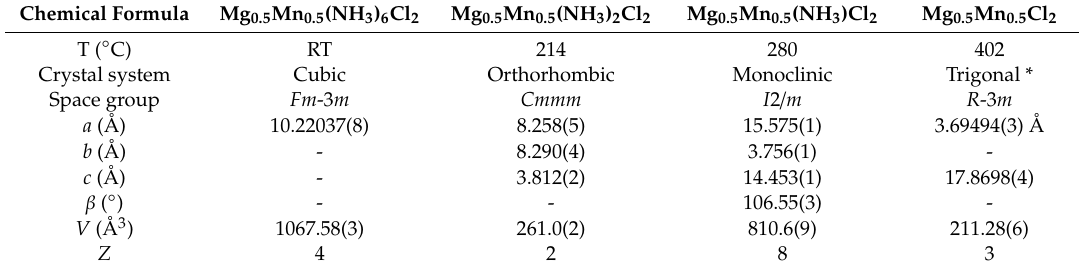
Table 2. Structural parameters for the present Mg 0.5 Mn 0.5 (NH 3 ) y Cl 2 (y = 6, 2, 1 and 0) phases investigated in this